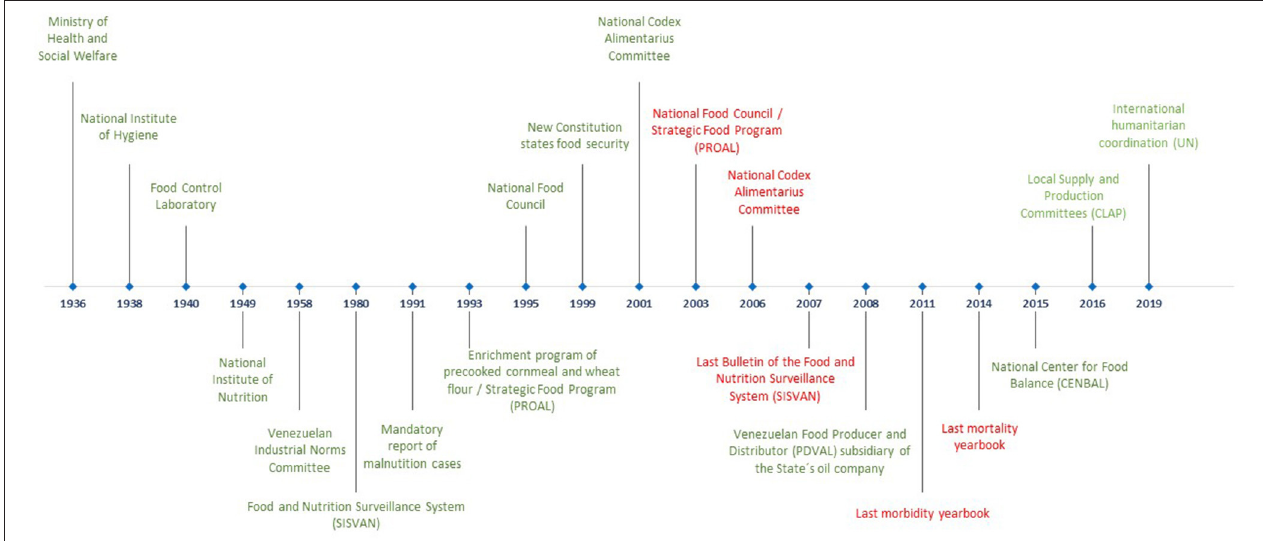
FIGURE 3 | Timeline of construction (in green) and dismantling (in red) of agencies and programs of the food and nutrition